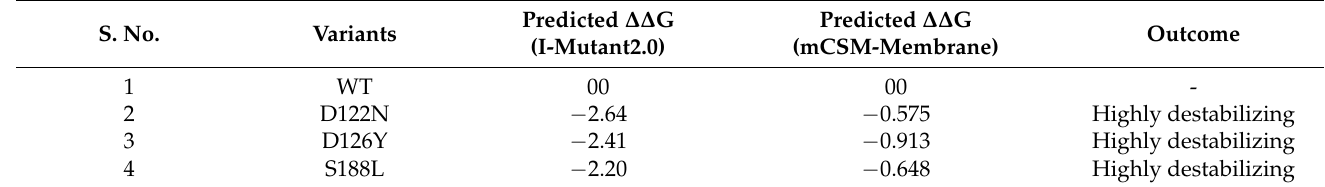
Table 1. Predicted protein stability scores of the mutants. The I-Mutant2.0 and mCSM-membrane predicted stability effects upon mutation. ∆∆ G < 0 (values of energies are given in kcal/mol) indicates a reduction in protein stability.